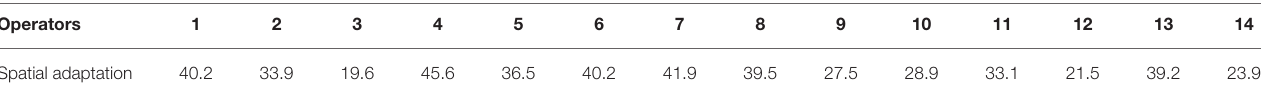
TABLE 4 | Spatial adaptation (%) of each operator.